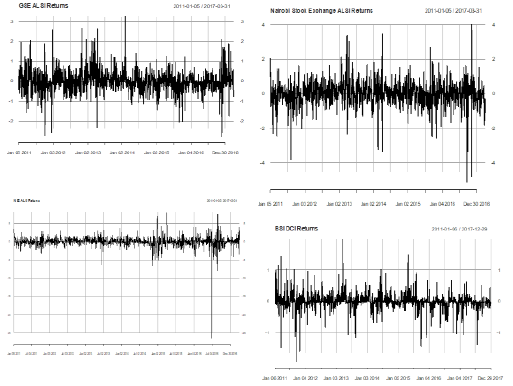
Figure 2. The Log-Returns of the Broad Market Indices